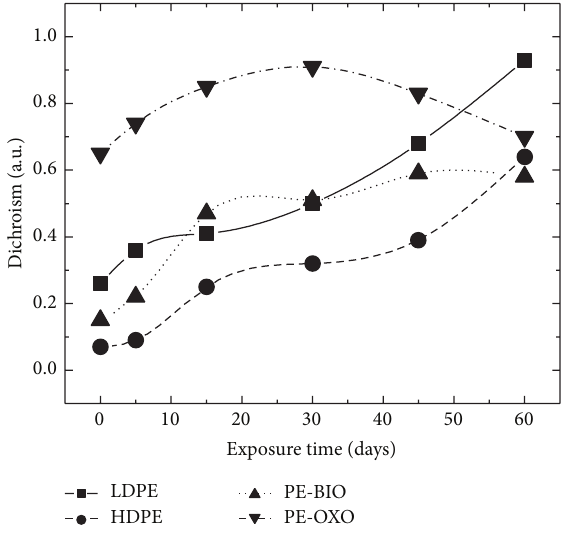
Figure 5: Dichroic ratio of the LDPE ( ◼ ), HDPE ( 󳵳 ), PE-BIO ( 󳶃 ), and PE-OXO ( e ) films exposed to UV-B